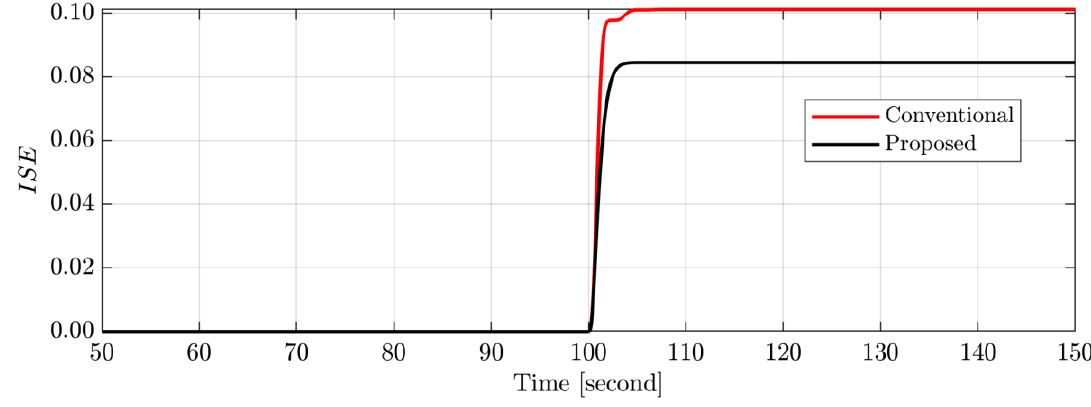
Figure 13. The system’s ISE objective function of the studied system for the case 2.